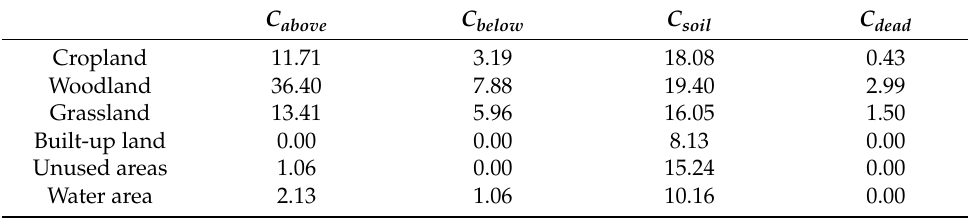
Table 3. Carbon density (Mg/ha) of different LULC in YZC. C above C below C